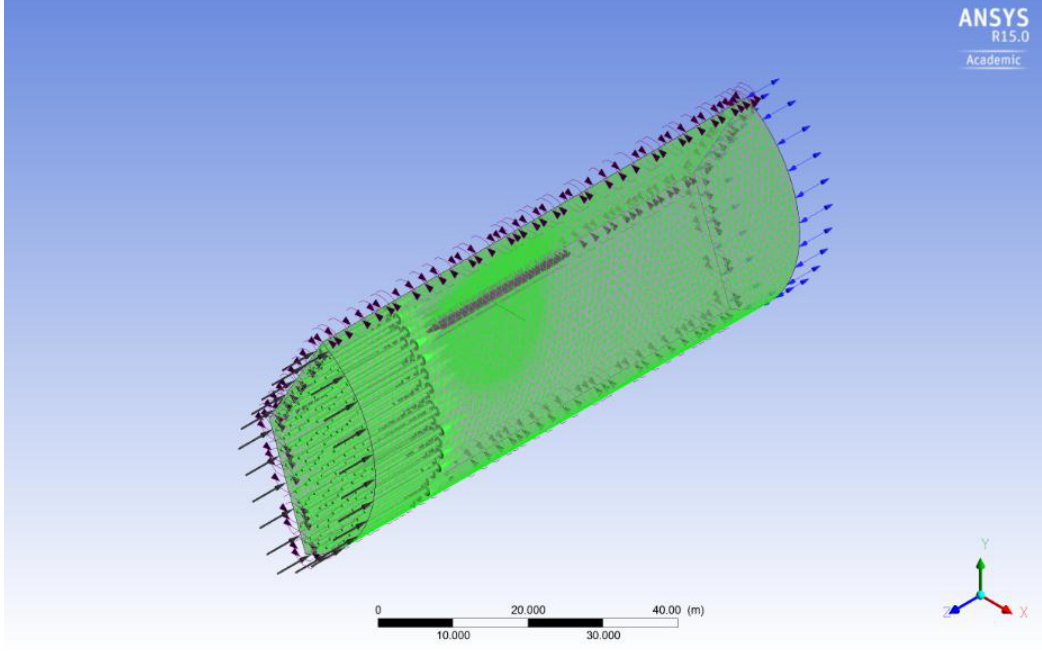
Figure 5. One third of the cylindrical fluid domain with boundary conditions.